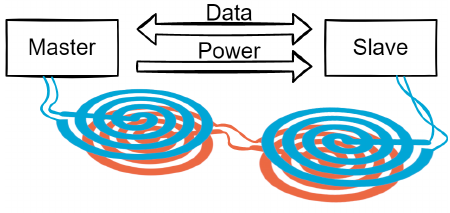
Figure 1. Illustration of the